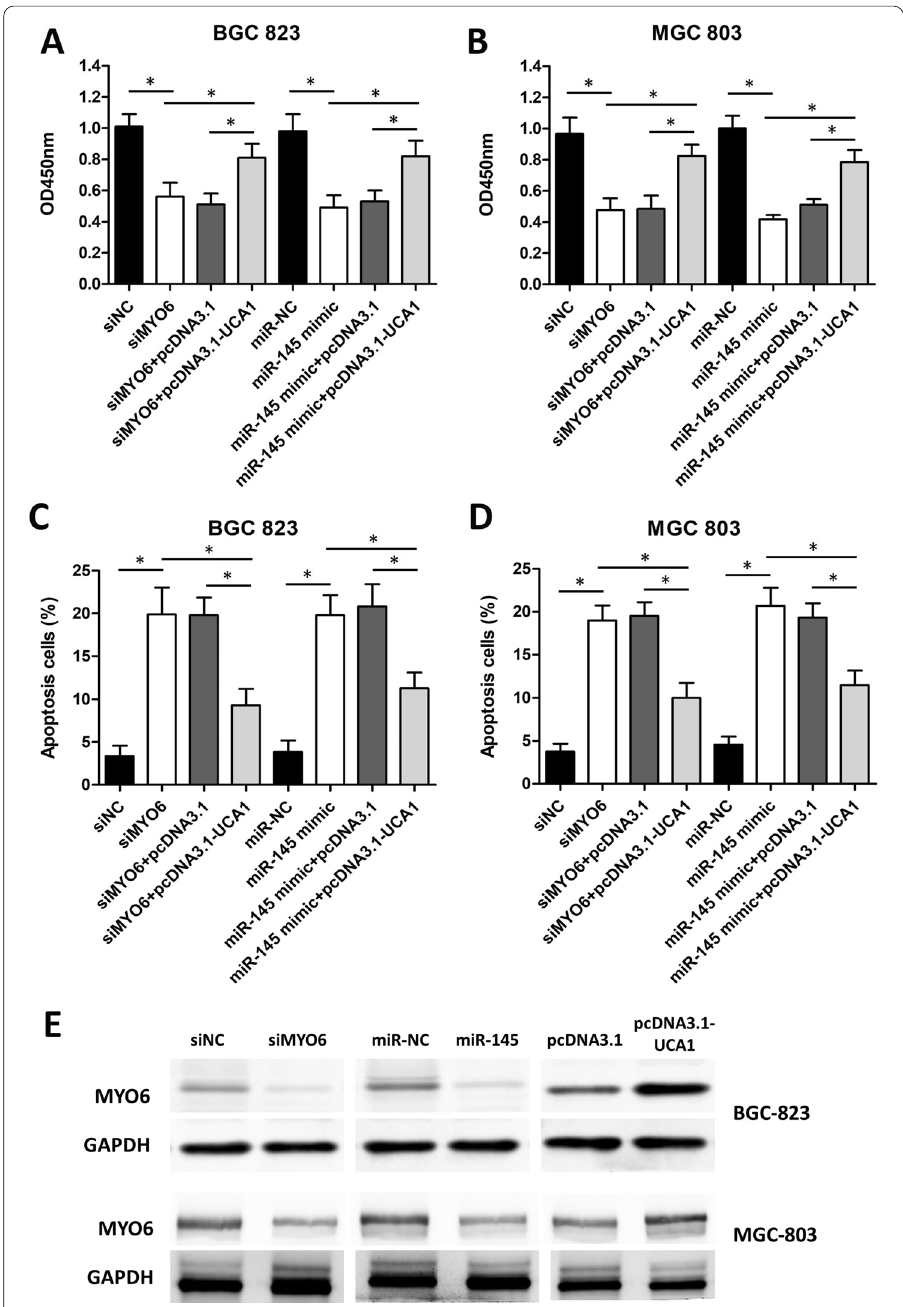
Fig. 9 UCA1 reverses the effect of the miR-145/MYO6 axis on GC cell proliferation and apoptosis. A CCK-8 assay showed that pcDNA3.1-UCA1 partially reversed the repression effect of miR-145 mimics or siMYO6 on BGC-823 cell proliferation. B CCK-8 assay showed that pcDNA3.1-UCA1 partially reversed the repression effect of miR-145 mimics or siMYO6 on MGC-803 cell proliferation. C Flow cytometry assay showed that the increased apoptosis induced by miR-145 mimics or siMYO6 in BGC-823 cell lines was suppressed by pcDNA3.1-UCA1 co-transfection. D Flow cytometry assay showed that the increased apoptosis induced by miR-145 mimics or siMYO6 in MGC-803 cell lines was suppressed by pcDNA3.1-UCA1 co-transfection. E Western blot results showing MYO6 expression in BGC-823 and MGC-803 cells after siMYO6, miR-145 mimics, or pcDNA3.1-UCA1 transfection. *p < 0.05, compared with control